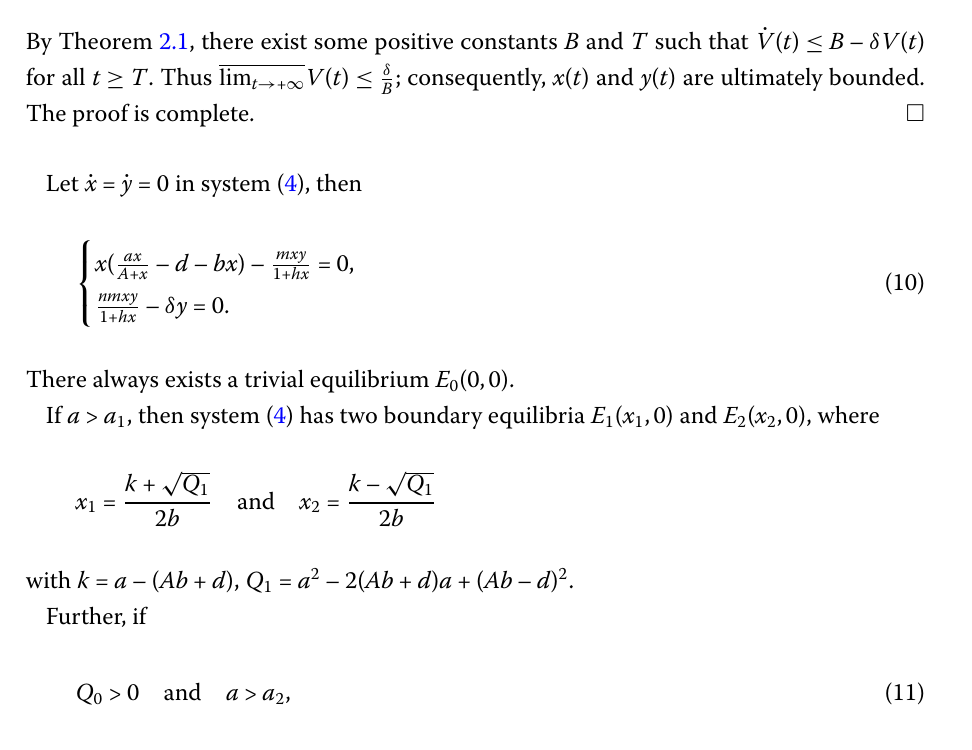
Figure 2 Dynamic behaviors of system (1) with A = 0.5, d = 2, b = 5, and a =